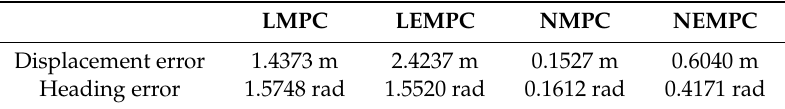
Table 4. The maximum absolute values when velocity is 4 m / s.